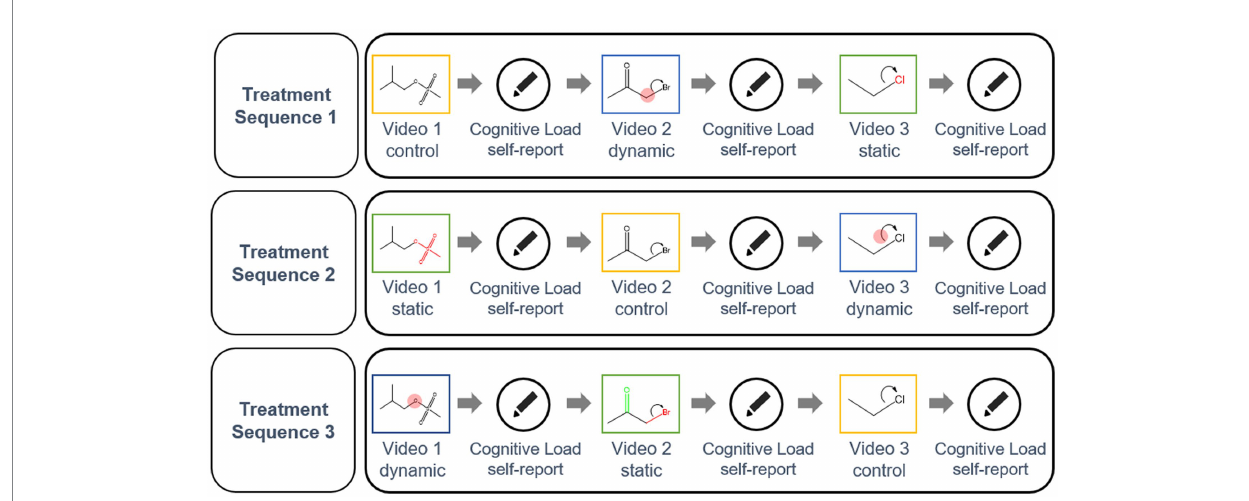
FIGURE 1 Experimental 3 × 3 Latin Square design showing signaling condition, instructional video and treatment sequence. The boxes display a screenshot from the chemical representations that were explained in the videos and the design of the signaling conditions. All participants received the instructional videos in the same order with regards to content, while the order of the signaling condition differed according to their treatment